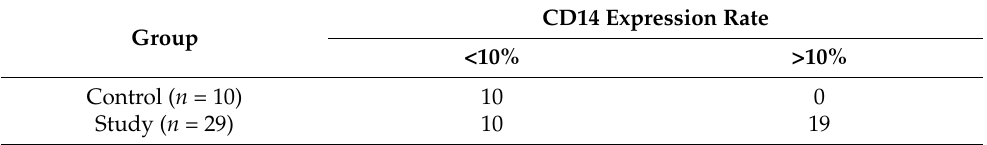
Table 3. CD14 expression rate in the study group and the control group and age